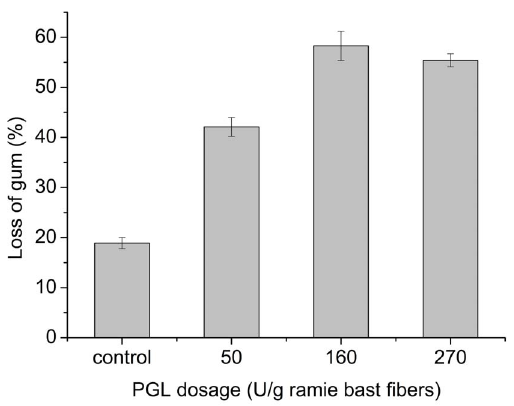
Figure 7. Degumming effectiveness of PGL crude enzyme in different PGL